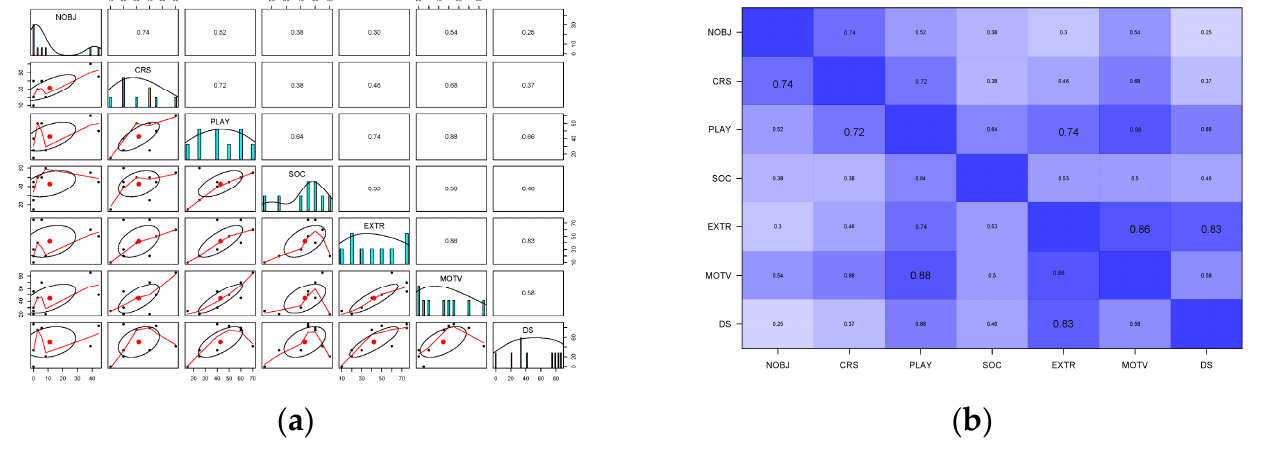
Figure 7. Correlation matrix of personality traits, DS and frequency of novel object interaction. ( a ) Correlation plot pairs for multiple correlations, ( b ) Correlation plot matrix.